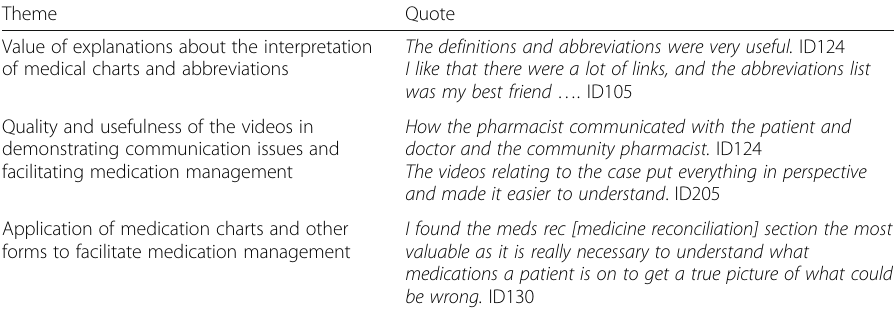
Table 6 Positive qualitative feedback themes